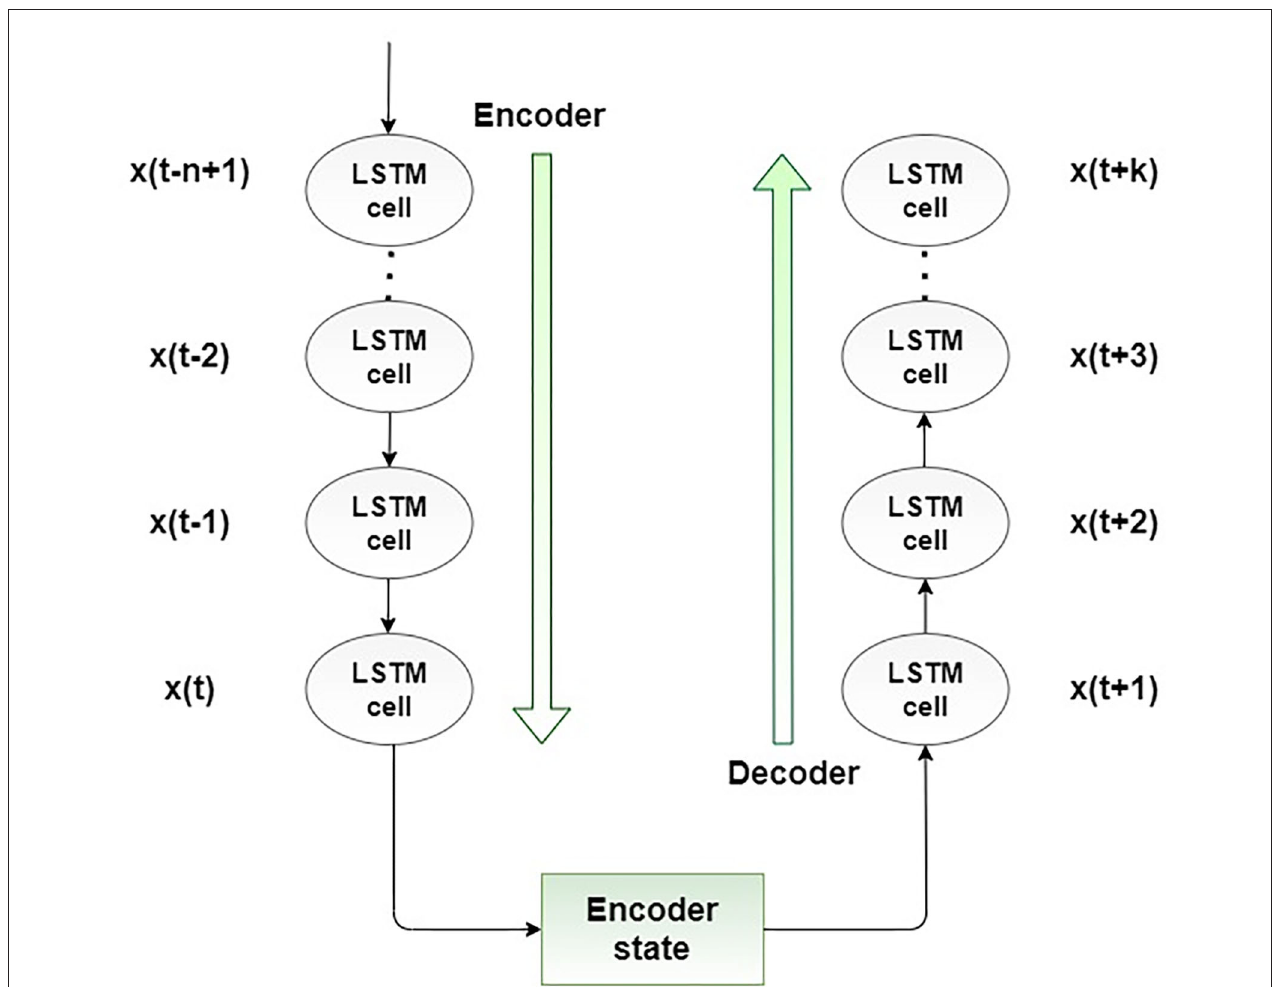
FIGURE 3 | Proposed encoder-decoder LSTM structure.